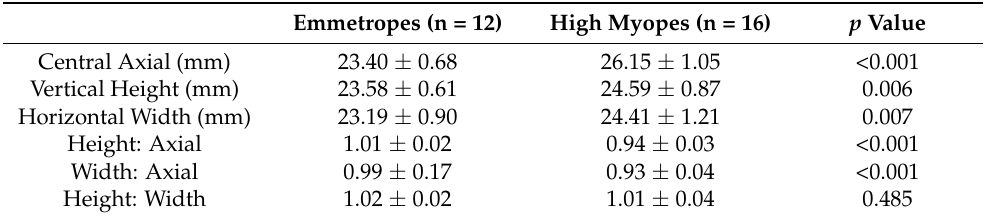
Figure 3. There were significant differences in the vertically measured peripheral refraction between the emmetropic and high myopic groups in ( a ) Spherical equivalents at all of the eccentricities (* p < 0.001); ( b ) Tangential refractive error (FT’) (* p < 0.01) at all of the eccentricities; ( c ) Sagittal refractive error (FS’) at all the eccentric angles (* p < 0.01). Table 2. The mean axial length, height, width and the dimensional ratios of the emmetropic and highly myopic